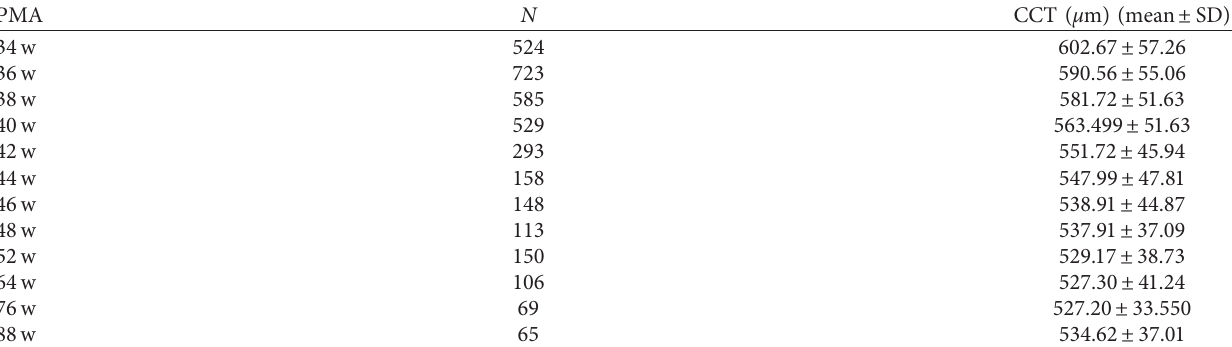
Table 2: Mean CCT at each PMA.